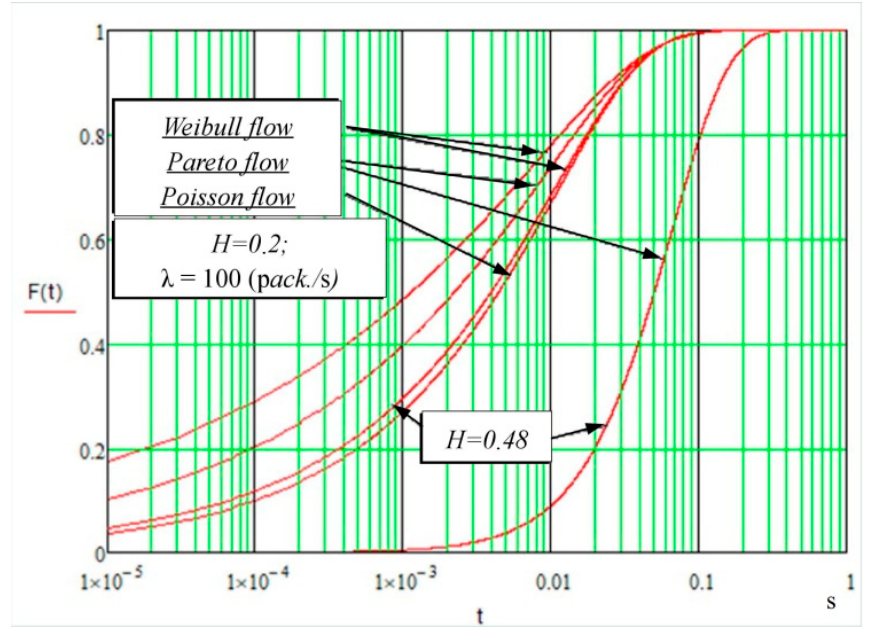
Figure 8. The graphs of the distribution functions of the delivery time of data packets, if there are different models of network traffic.